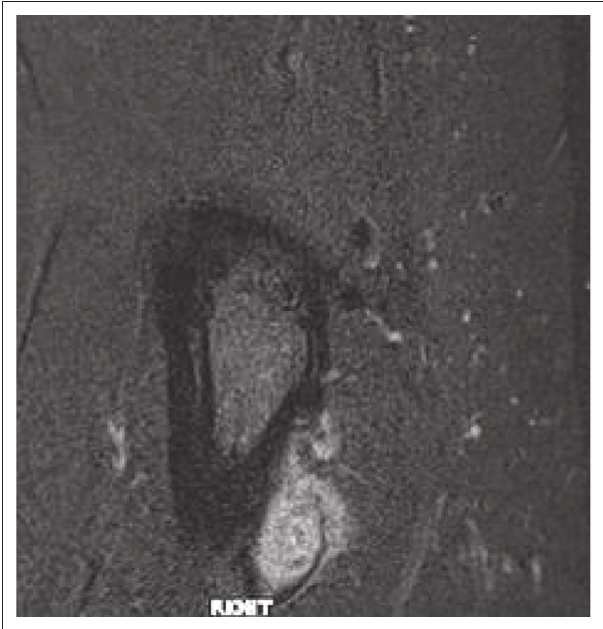
FIGURE 3: Sagittal proton-density MR image of the right hip.